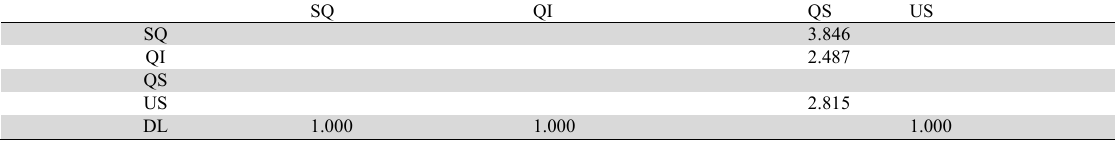
The results of Collinearity (Inner VIF Values)